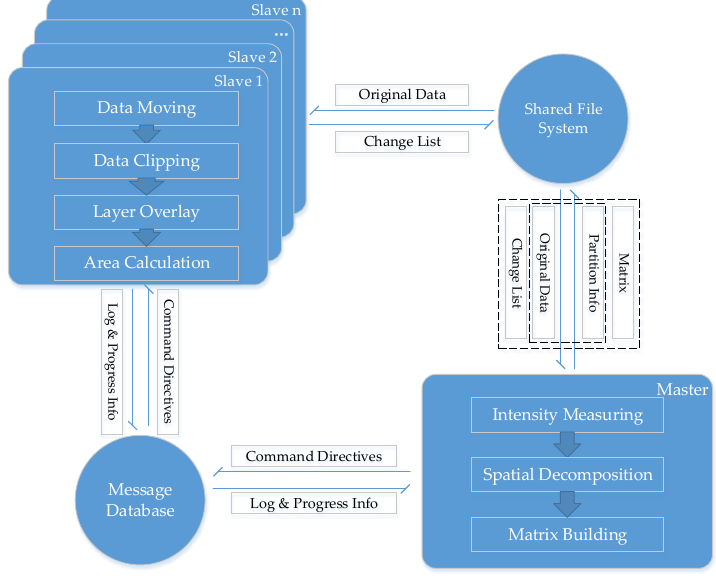
Figure 4. Master-slave architecture for distributed workstations.